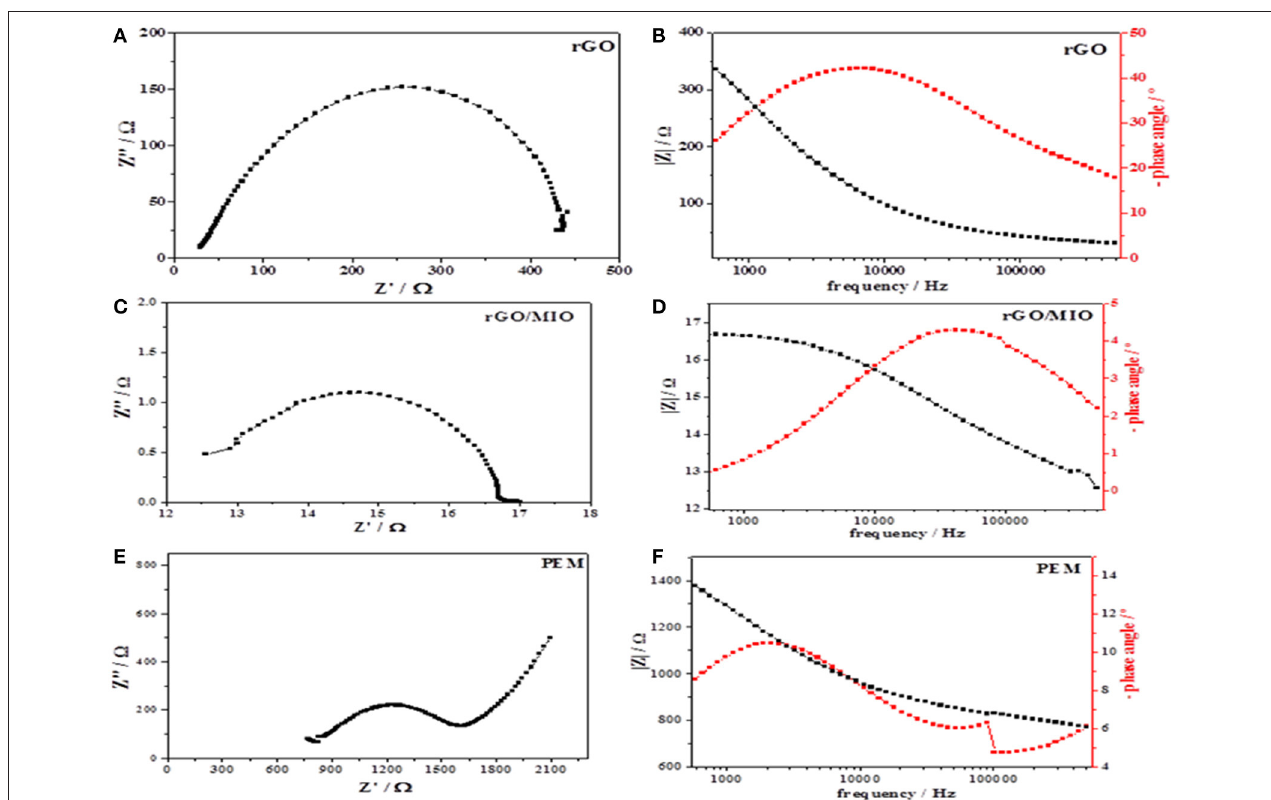
FIGURE 5 | Nyquist (A,C,E) and Bode (B,D,F) plots obtained for the rGO anode, the rGO/MIO cathode and for the PEM fuel cell.